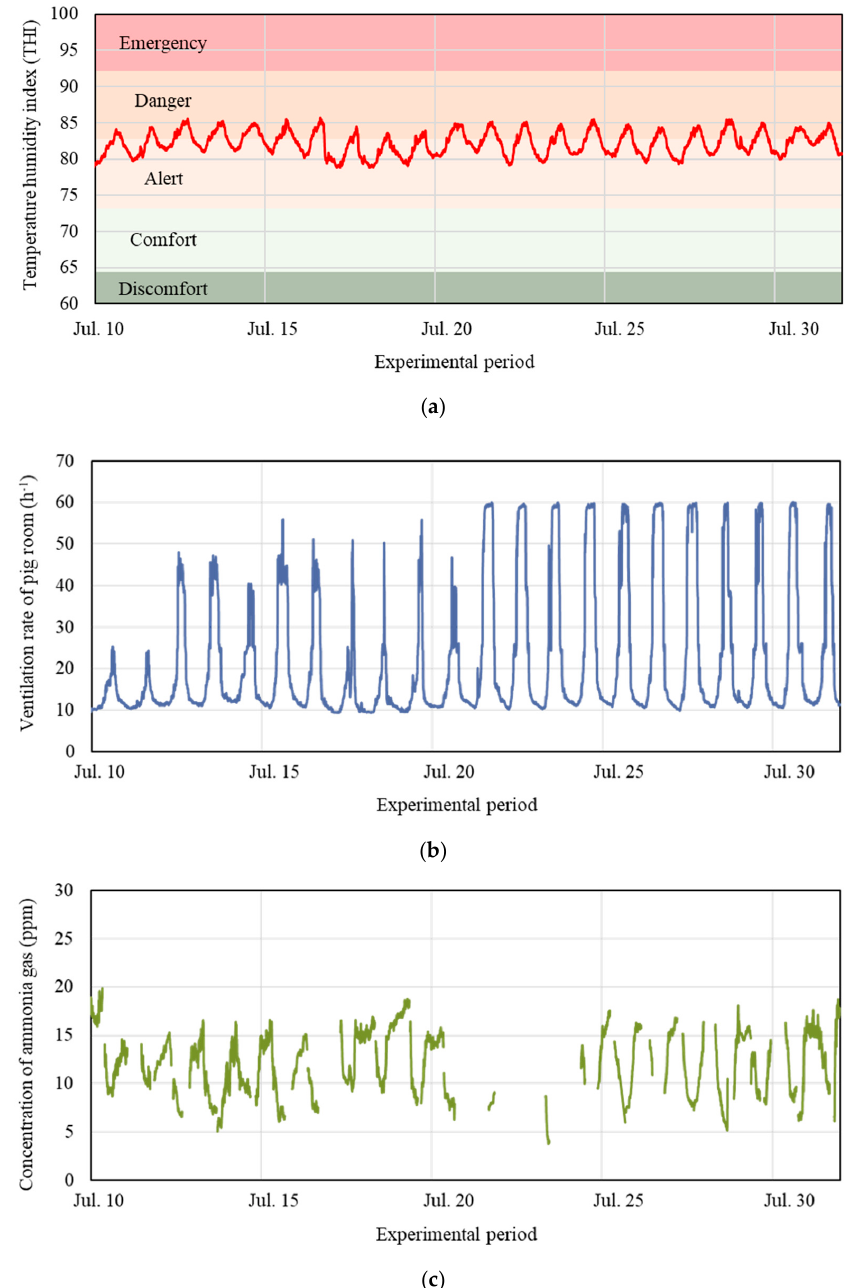
Figure 9. The evaluation results of the breeding environment inside the experimental pig house. ( a ) Temperature humidity index. ( b ) Ventilation rate of the pig room. ( c ) Concentration of ammonia gas inside the pig room.